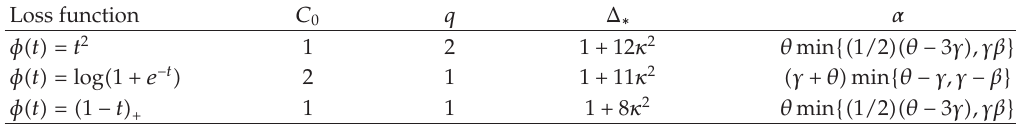
Table 1: The values of parameters for di ff erent convex